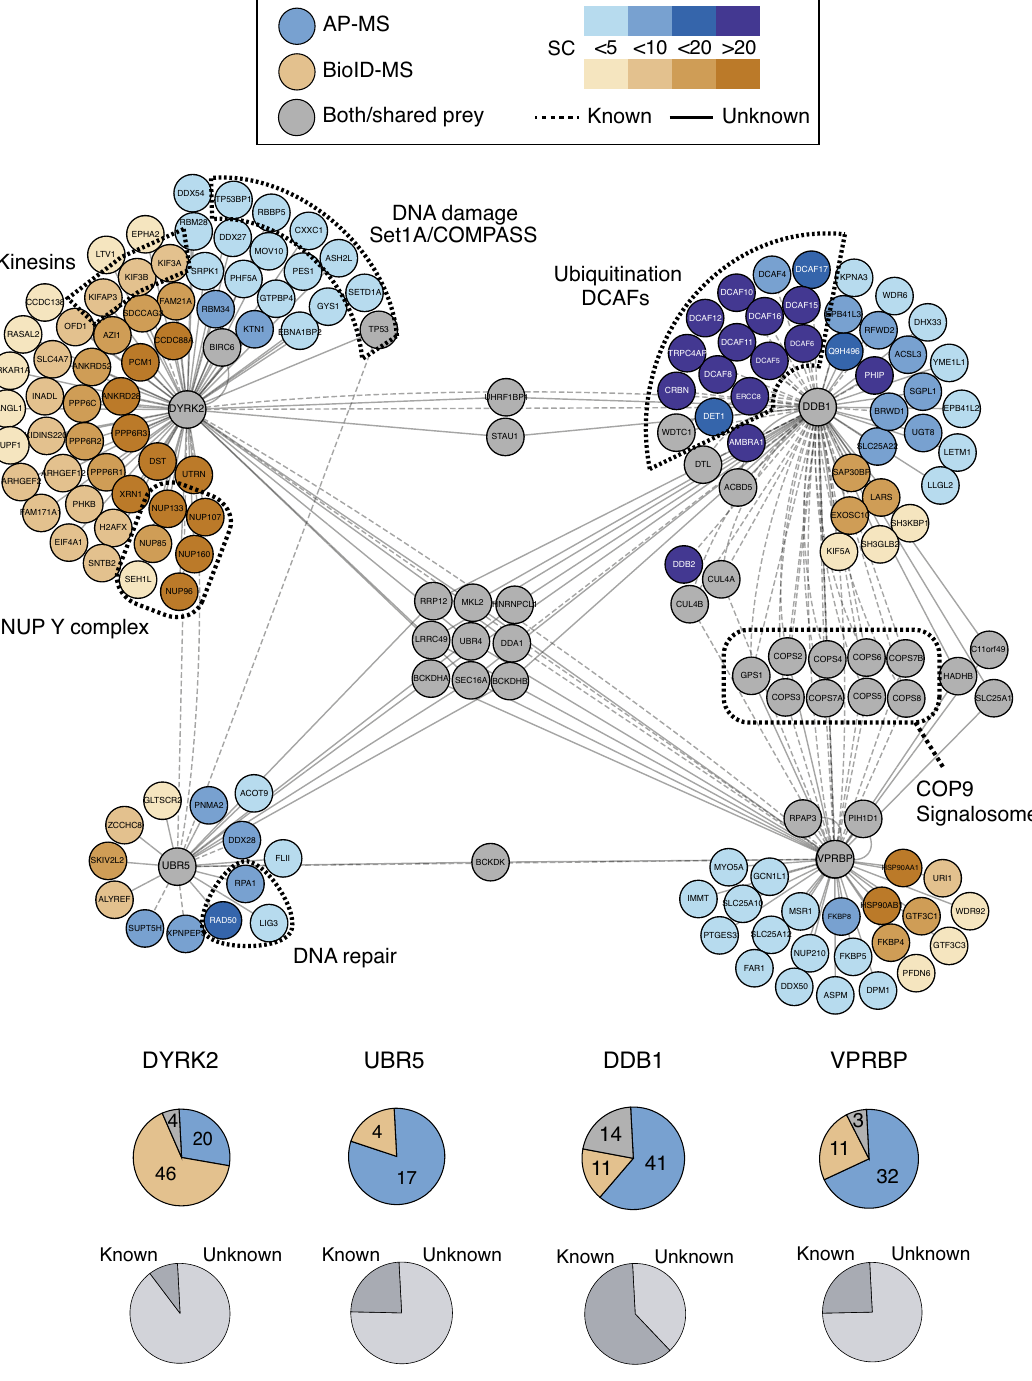
Fig. 2 Comprehensive interaction network of the wild-type Dyrk2 – EDVP complex. Interaction network of the Dyrk2 – EDVP complex. Interactors identi fi ed by AP – MS are shown in blue, interactors identi fi ed by BioID – MS are shown in brown, interactors identi fi ed by both methods are shown in gray. The intensity of the color indicates the number of spectral counts that was assigned to the respective interaction partner. The upper pie charts indicate the number of interactors for the respective bait protein identi fi ed by AP – MS or BioID – MS. The lower pie charts show the distribution of known and previously unknown interactors,